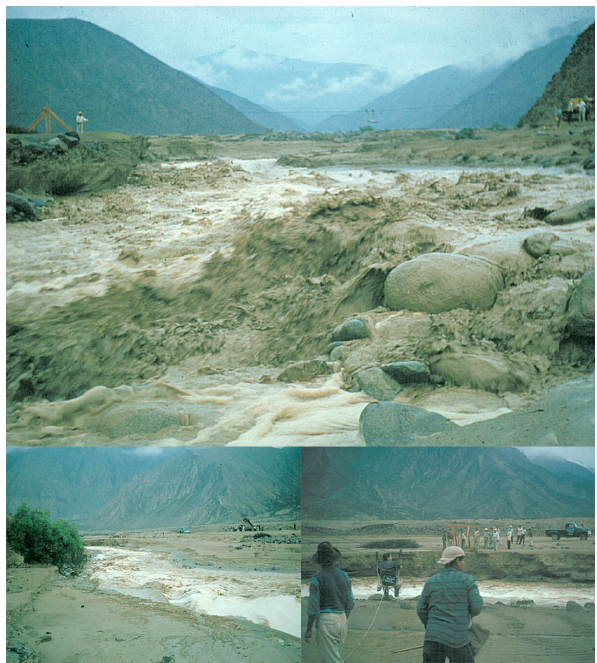
Figure 6. Pictures of the huayco (mud flash flood) events on 1961 that blocked the road to the observatory. A rescue mission had to be arranged in order to help Jicamarca workers leave the observatory. The project was stopped for several